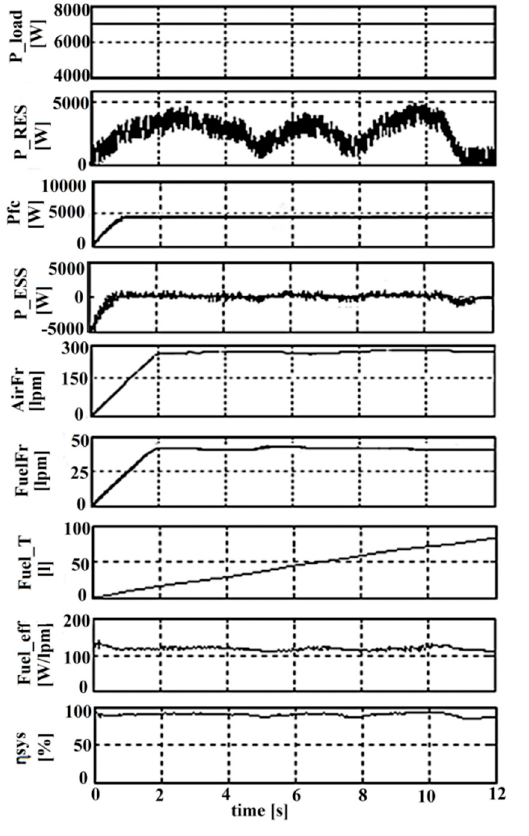
Figure 8. Air-LFW-based strategy.